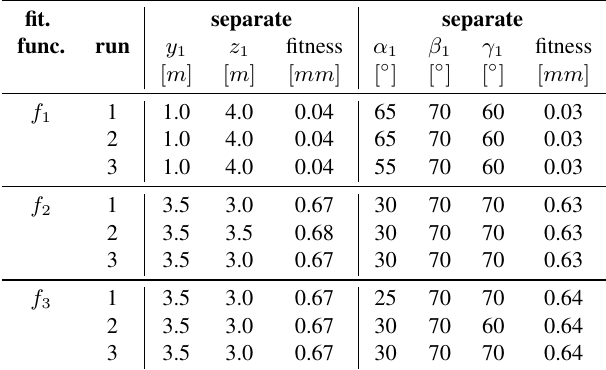
and the rotations